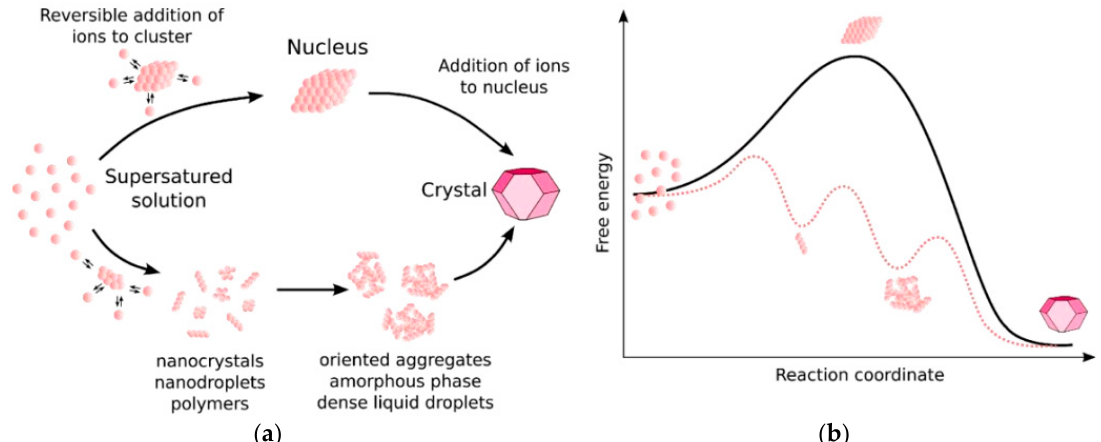
Figure 7. ( a ) Possible pathways for crystal growth according to a classical (upper) and non-classical (lower) theory. ( b ) Associated energies for a one-step process (solid line) and a multi-step process (dotted line). Figure from Van Driessche et al. (2019) [69].